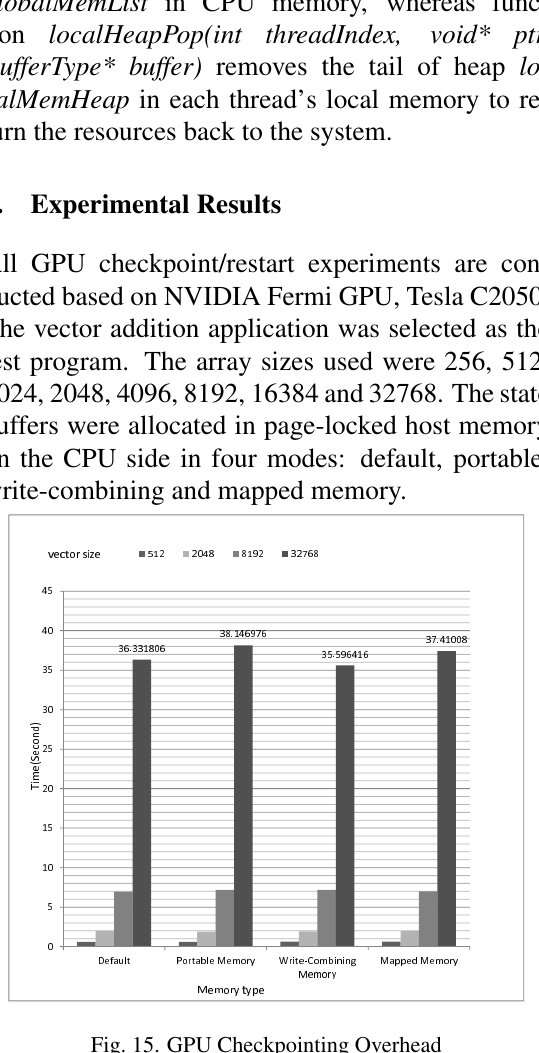
Fig. 15. GPU Checkpointing Overhead